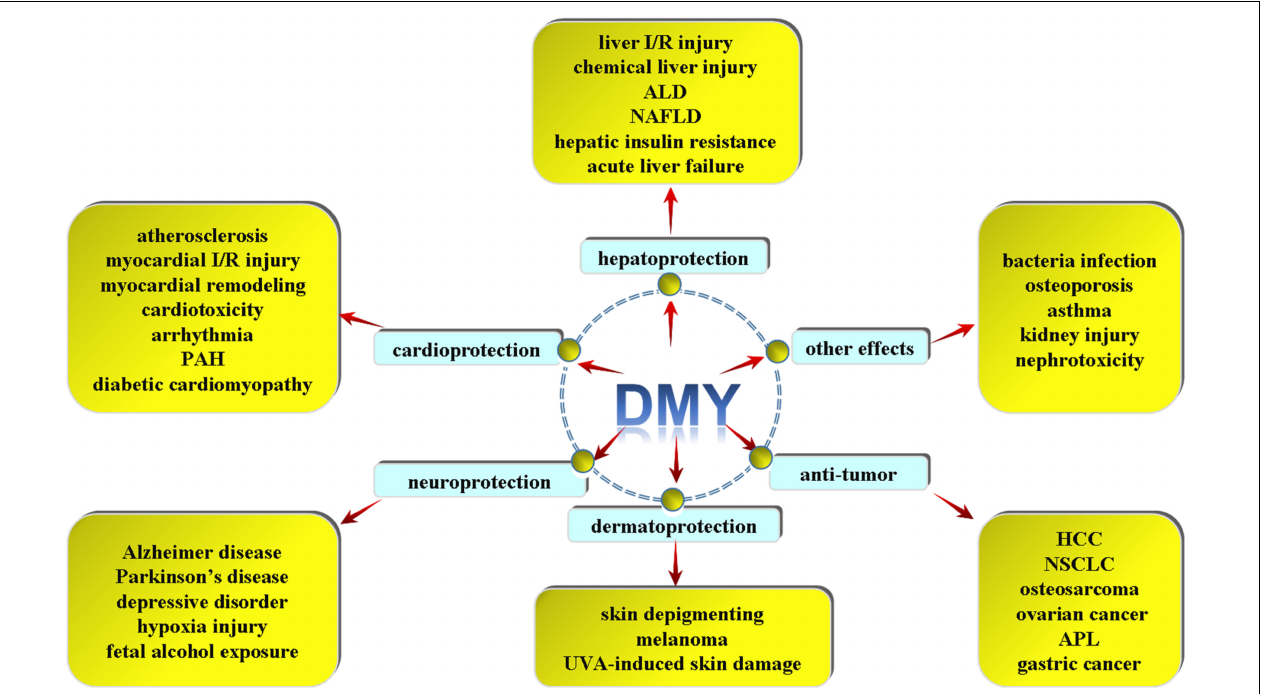
FIGURE 2 | Different pharmacological effects of DMY. DMY exhibits powerful cardioprotection on atherosclerosis, myocardial ischemia reperfusion (I/R) injury, myocardial remodeling, adriamycin-induced cardiotoxicity, arrhythmia, pulmonary artery hypertension (PAH) and diabetic cardiomyopathy (DCM). DMY protects against liver I/R injury, chemical liver injury, alcoholic liver disease (ALD), non-alcoholic fatty liver disease (NAFLD), hepatic insulin resistance and acute liver failure. DMY has been shown to protect against Alzheimer disease (AD), Parkinson’s disease (PD), depressive disorder, hypoxia injury and fetal alcohol exposure induced brain injury. DMY is also indicated to suppress hepatocellular carcinoma (HCC), non-small cell lung cancer (NSCLC), osteosarcoma, ovarian cancer, acute promyelocytic leukemia (APL) and gastric cancer. DMY is beneficial for skin depigmenting, melanoma and UVA-induced skin damage. And DMY was applied for